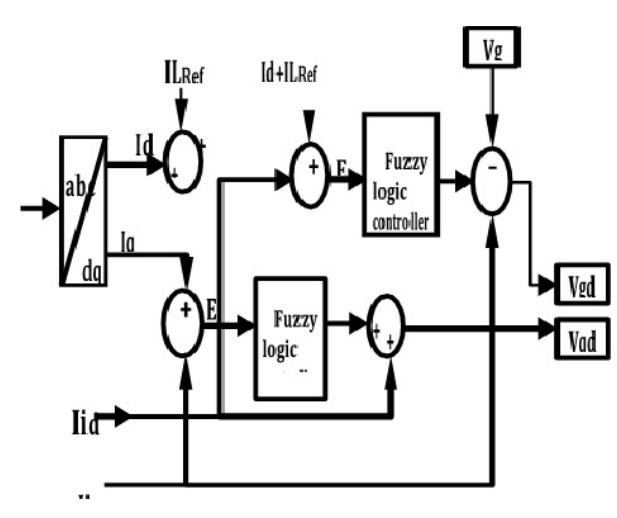
Figure 3. Block Diagram of Proposed Synchronous Rotating Frame